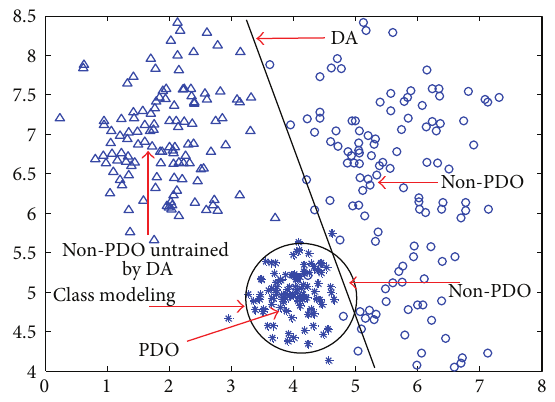
Figure 1: The discrimination of PDO and non-PDO samples by fusion of DA and class modeling.